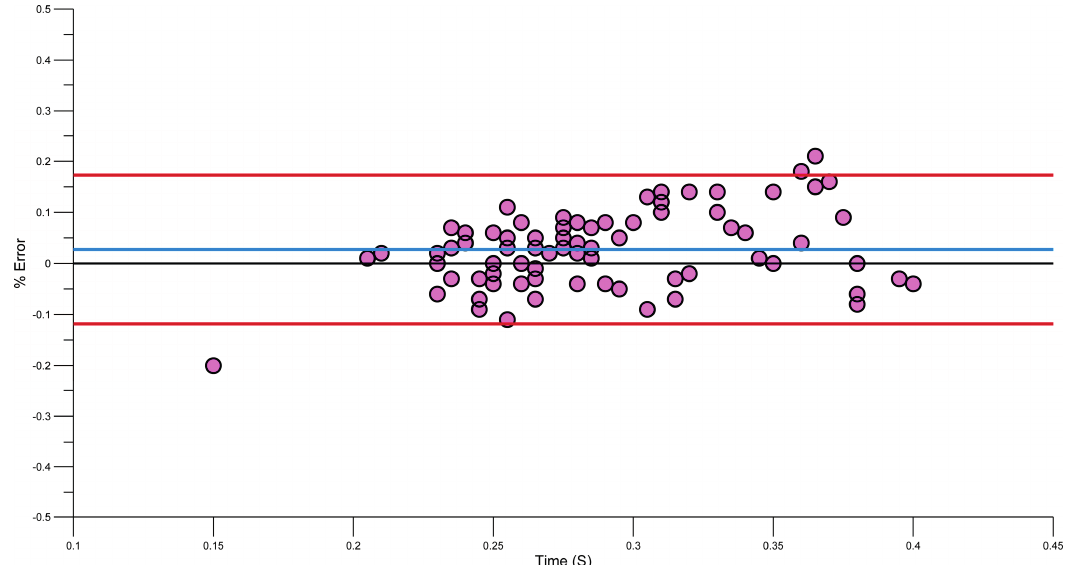
Figure 14. Bland-Altman plot of Push Duration Error.